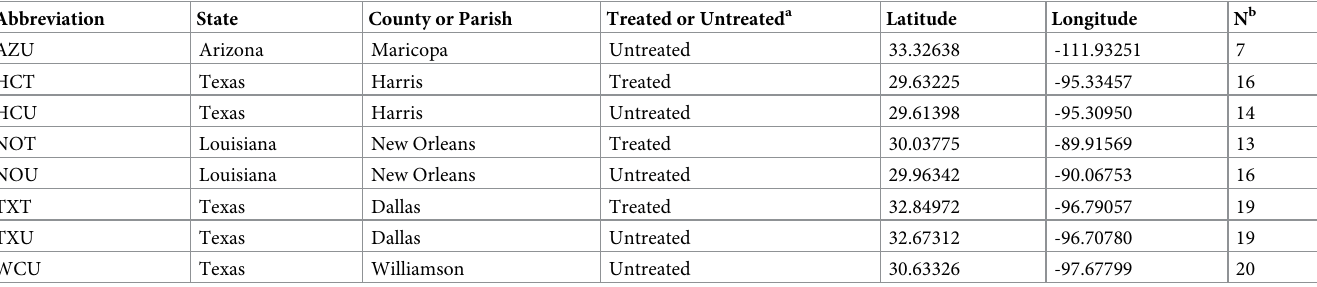
Table 1. Collection information for Culex quinquefasciatus specimens used in this